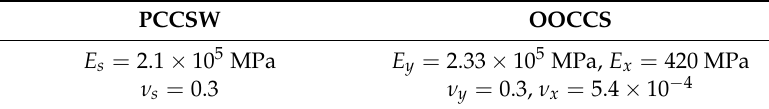
Table 1. Material constants needed in numerical simulation of Shinkai Bridge [31] as an